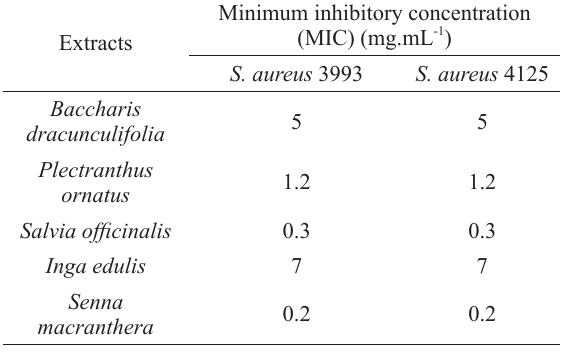
Values of minimum inhibitory concentrations (mg.mL -1 ) obtained for the active plant extracts.